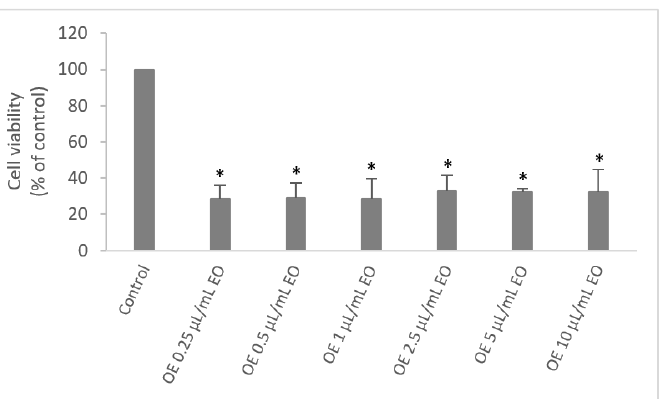
Figure 2. Effect of Lavandula stoechas subsp. luisieri essential oil on NHDF cell viability (MTT assay). Results are expressed as a percentage of MTT reduction by control cells maintained in a culture medium. Each value represents the mean ± SD from triplicates (* p < 0.01 compared to control).